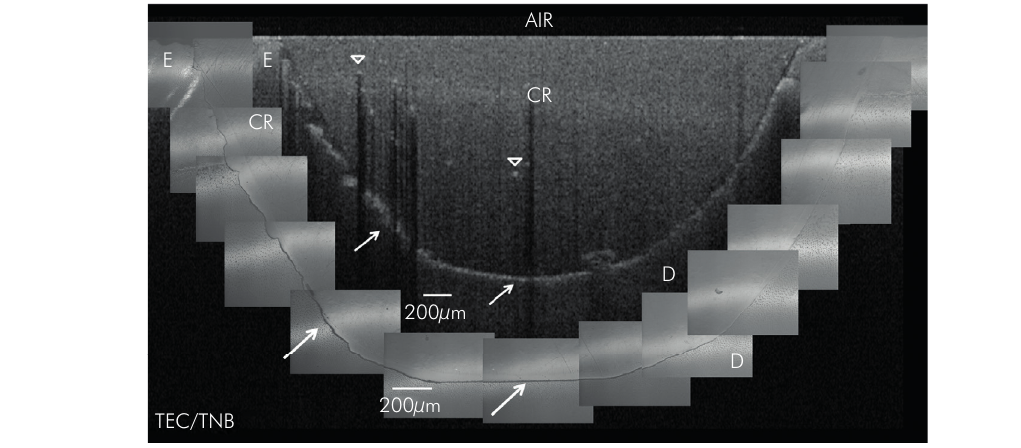
Figure 5. Representative 2D OCT image of TEC/TNB and its corresponding CLSM image. Interfacial gaps, which exhibited brighter pixels in the OCT images, were confirmed by CLSM as pointed by the arrows. Due to the loss in signal intensity underneath possibly larger filler particles (blank arrow heads), part of the interface in the OCT was masked.